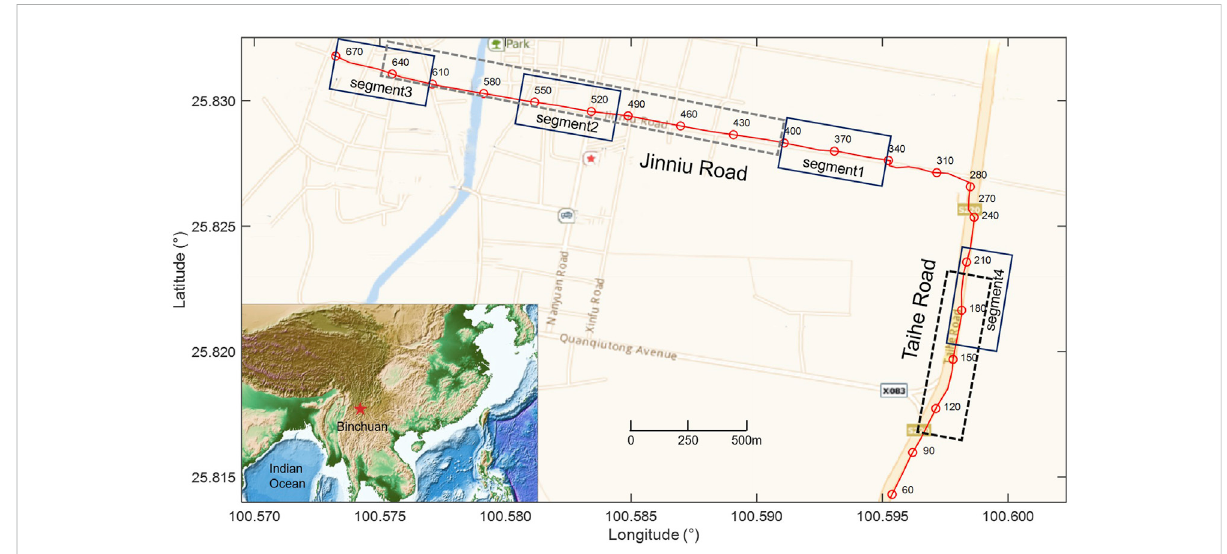
FIGURE 1 The location of the experiment. The red line is fi ber-optic cable, which is distributed along two streets (Taihe Road and Jinniu Road). The numbers around thered circles are thechannel indexes. The segments framed bythesolid and dashedlines are used for analysis in